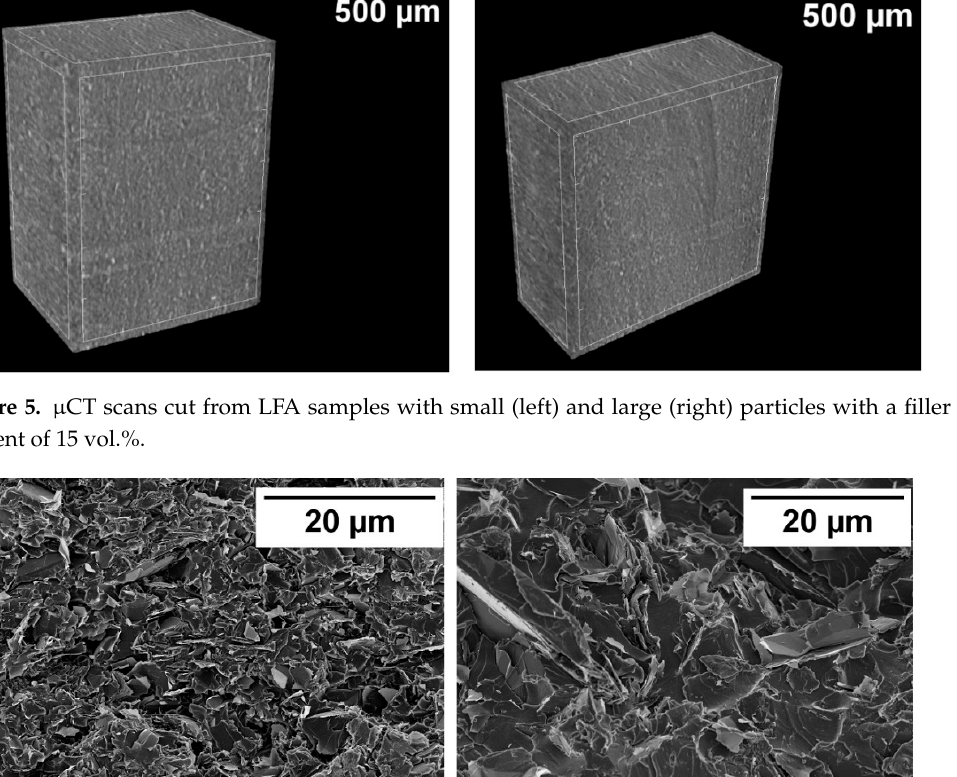
Figure 6. SEM of small (3.6 µ m) and large (18.4 µ m) graphitic particles at a magnification of 2 K. Samples from LFA have been broken manually.